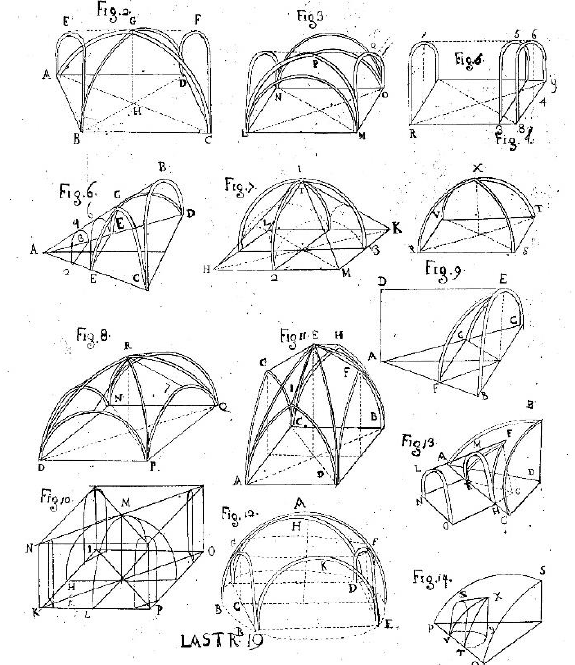
Figure 3. G. Guarini, Architettura Civile, Torino 1737, lastra XIX, trat. II.